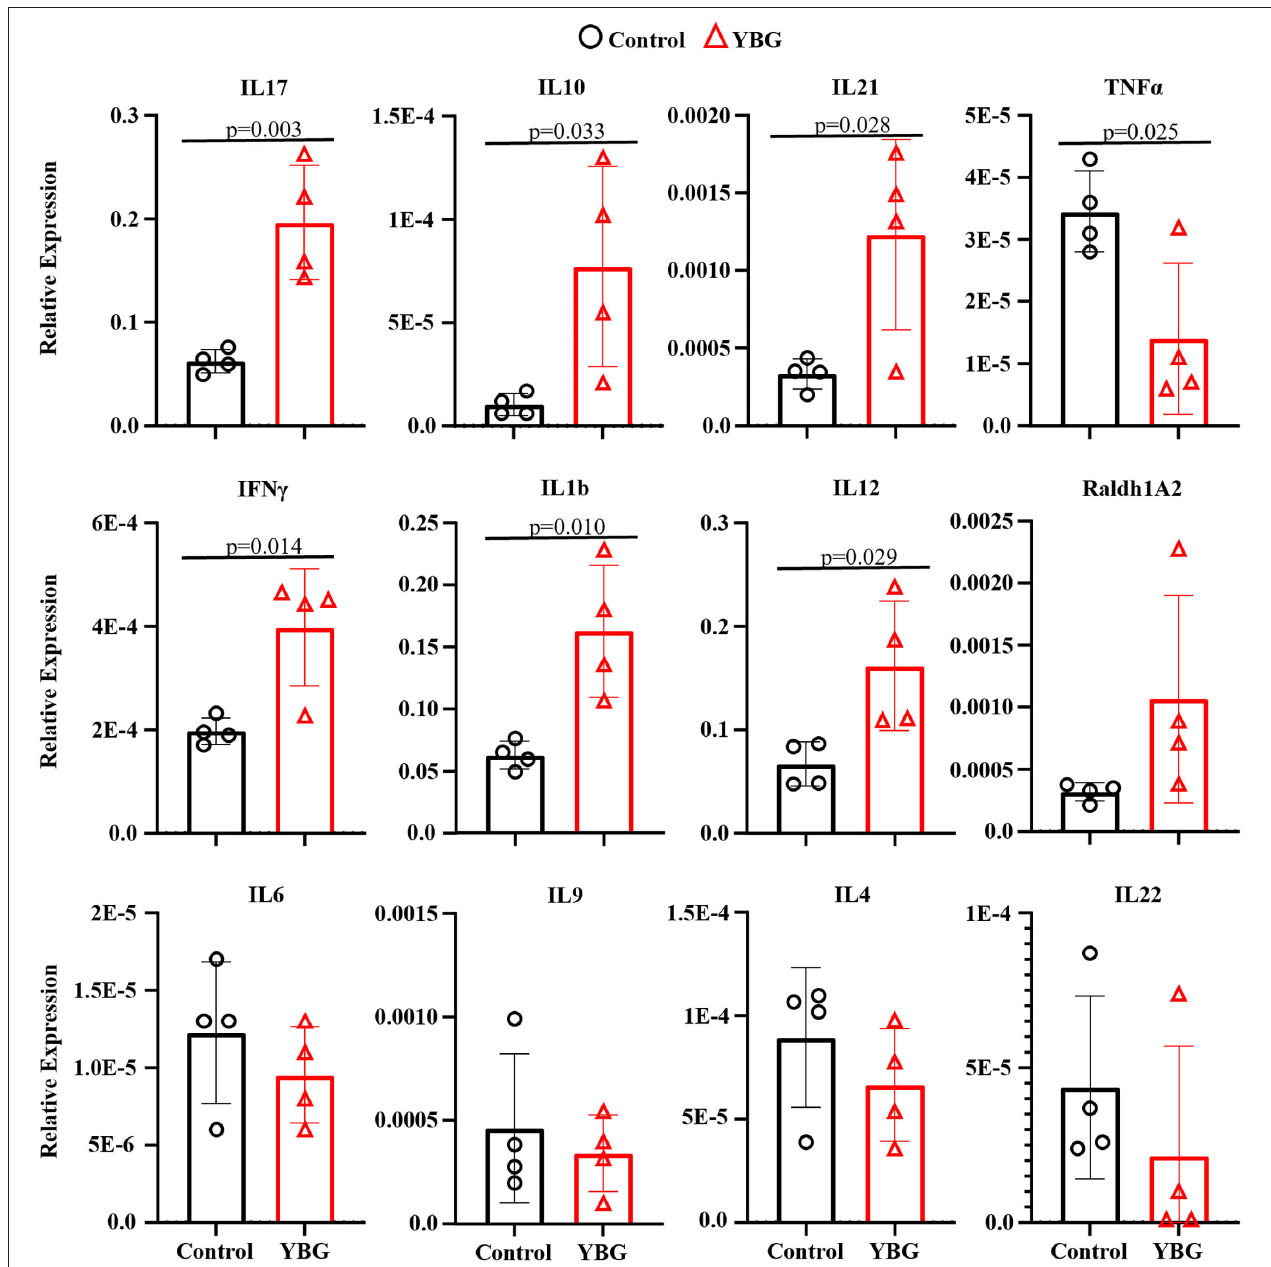
FIGURE 4 | YBG treatment for 30 days alters the immune phenotype of large intestine of NOD mice. Two-week-old female NOD mice were given YBG or control saline via oral gavage for 7 (5 mice/group) or 30 days (4 mice/group) consecutive days and were euthanized 24h after final treatment to harvest the intestine. cDNA was prepared from RNA extracted from the distal colon and RT-qPCR assay was performed to determine cytokine expression levels relative to β -actin expression. Assays were performed in triplicate for each sample, with P -values determined via Mann-Whitney test.